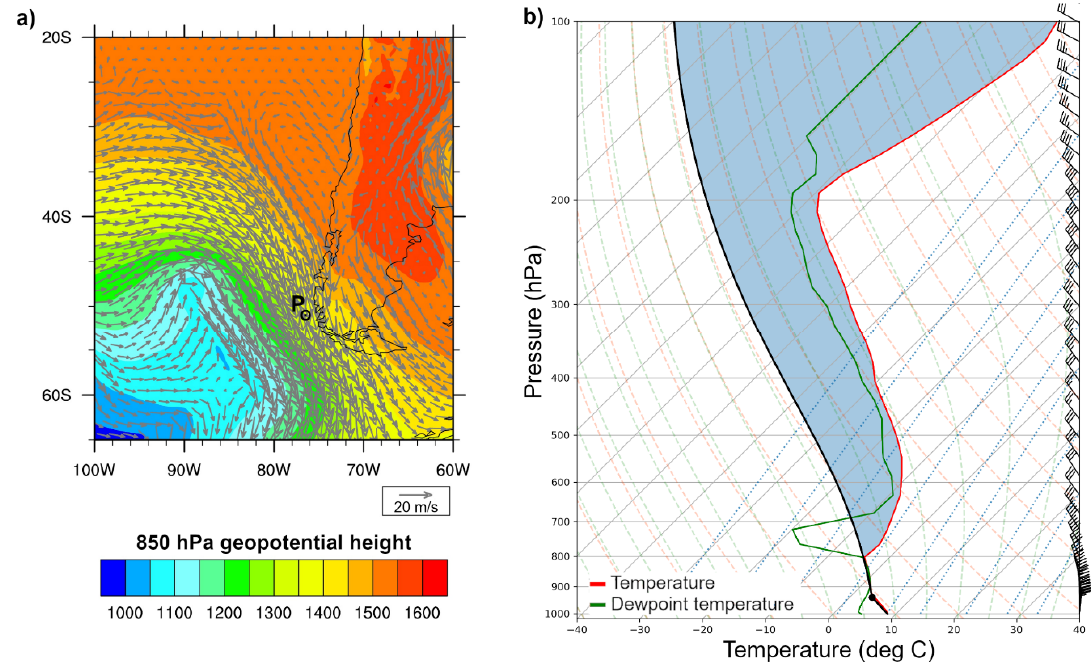
Figure 7. ( a ) Synoptic situation of 850 hPa geopotential height (color scheme) and wind vectors (arrows) derived from ERA5 and ( b ) skew-T diagram of upstream conditions, derived from WRF, at the location indicated by “P” in panel ( a ) for the transition case. Wind directions and speeds (one barb marks 10 m/s) are given on the right border.